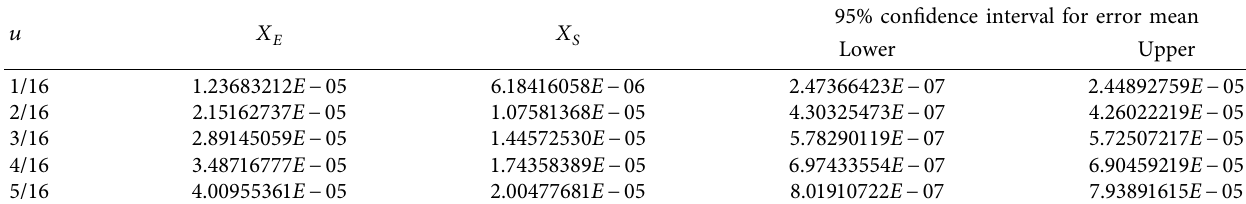
Table 1: When m � 16 and H � 0 . 6, the table exhibits numerical results of Example 1.